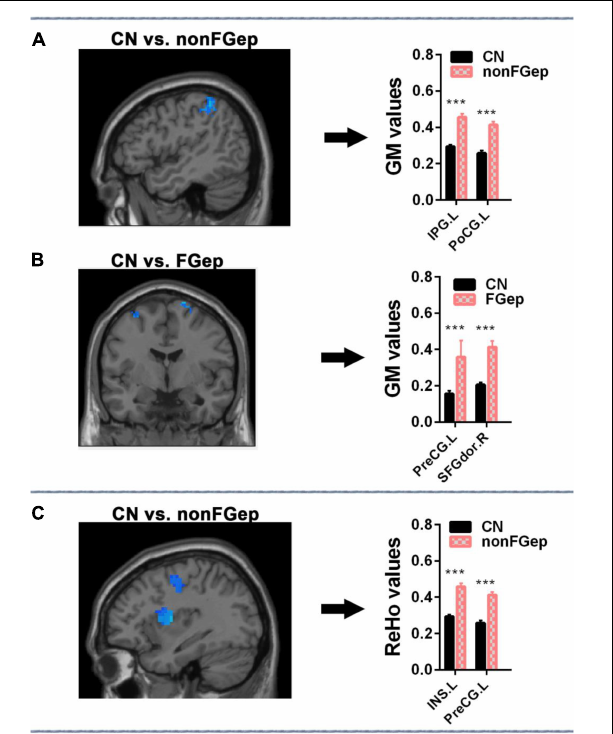
FIGURE 3 | Comparison of ReHo and GM within the executive control network among CN, non-FGep, and FGep subjects. (A) Altered regions of GM within the executive control network in non-FGep patients compared with CN. The bar chart on the right shows the quantitative comparison of GM in these altered regions. *** p < 0.001. (B) Altered regions of GM within the executive control network in FGep patients compared with CN. The bar chart on the right shows the quantitative comparison of FC in these altered regions. *** p < 0.001. (C) Altered regions of ReHo within the executive control network in non-FGep patients compared to CN. The bar chart on the right shows the quantitative comparison of ReHo in these different regions. *** p < 0.001. CN, healthy controls; non-FGep, frontal glioma without epilepsy; FGep, frontal glioma with epilepsy; PreCG, Precentral gyrus; INS, Insula; PoCG,